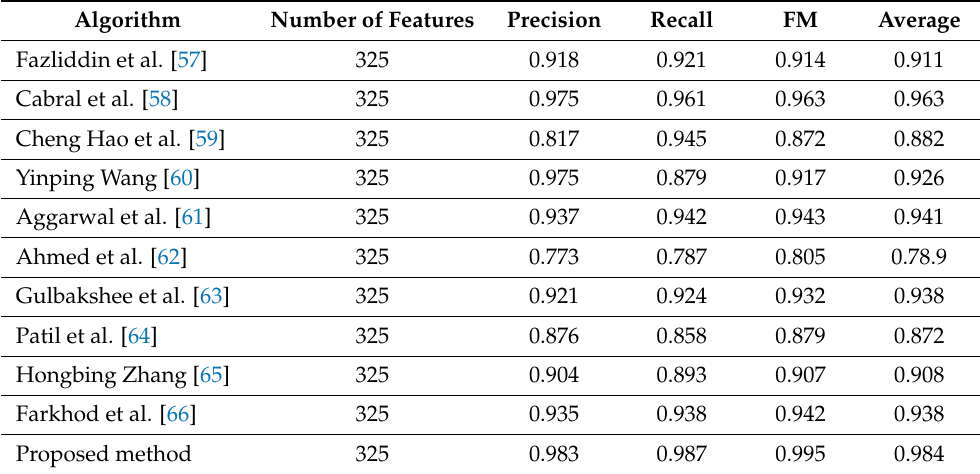
Table 6. Quantitative accuracy results of speech feature